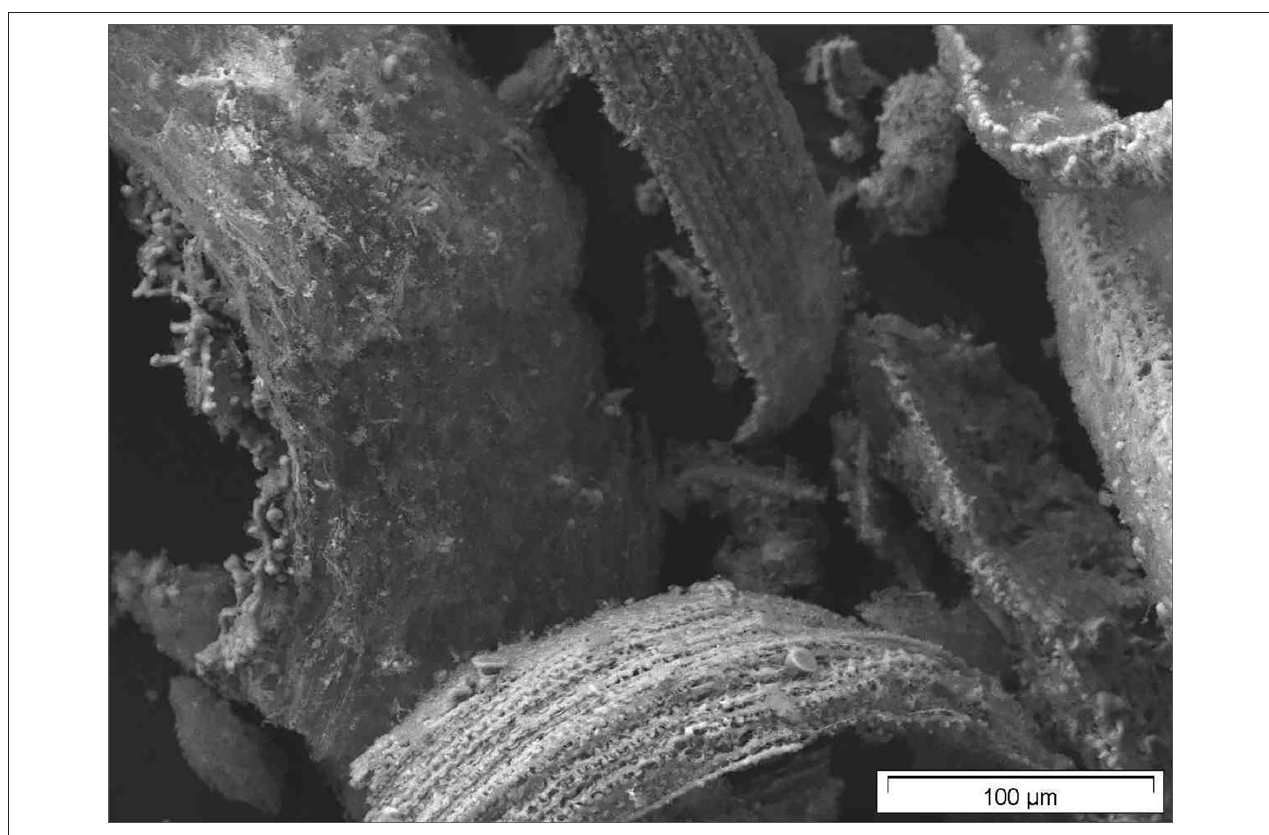
FIGURE 9 | SEM micrograph of calcined oat husk (calcined raw